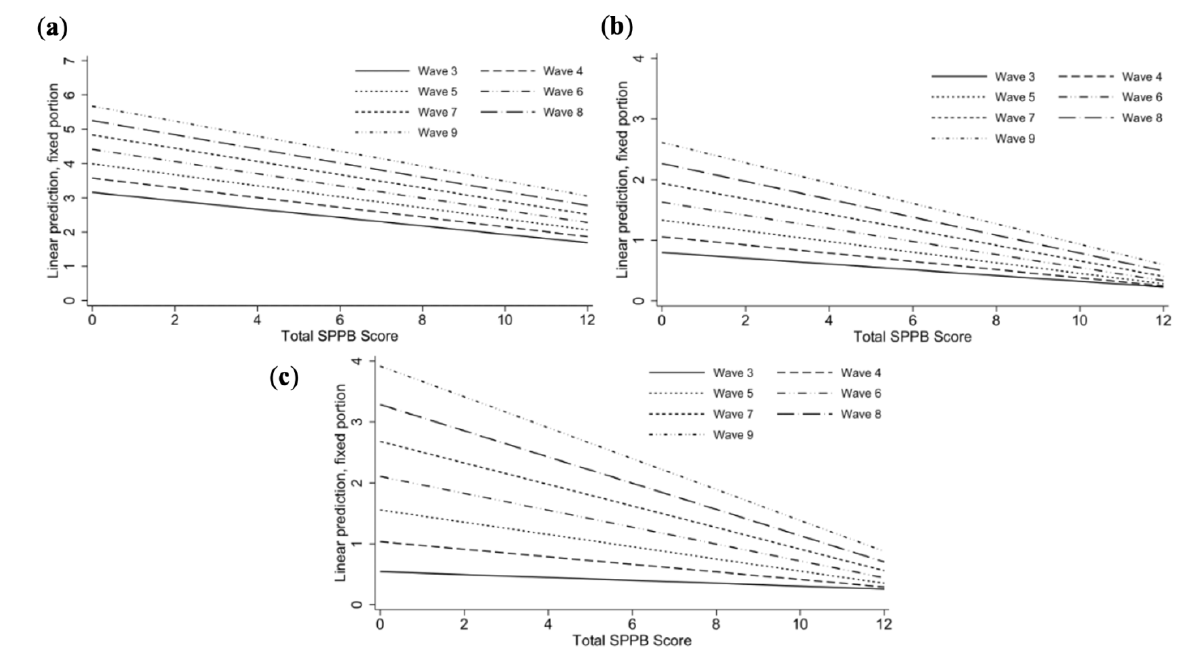
Figure 1. Simple slopes for the relationship between the total SPPB score at baseline and mobility impairment ( a ), ADL disabilities ( b ), and IADL disabilities ( c ) at different follow-up waves. Note: The predicted margins were derived from Model 11 for mobility impairment ( a ), Model 9 for ADL disabilities ( b ), and Model 11 for IADL disabilities ( c ). The values were computed using the postestimation “margins” command with the “vce(unconditional)” option. The random effects of the respective multilevel models were fixed to zero. The simple slopes show the amount of change in each outcome for a one-point increase in the total SPPB score at baseline while holding time (wave of follow-up) constant at different values.